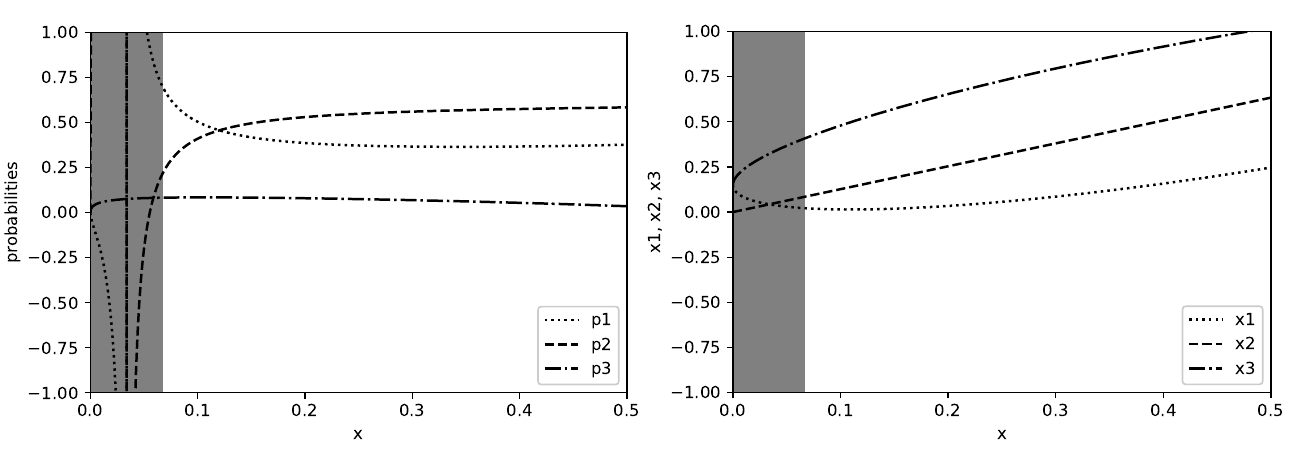
Figure 5. Graphs of p 1,2,3 ( Left ) and x 1,2,3 ( Right ) as functions of x with fixed z . Gray area